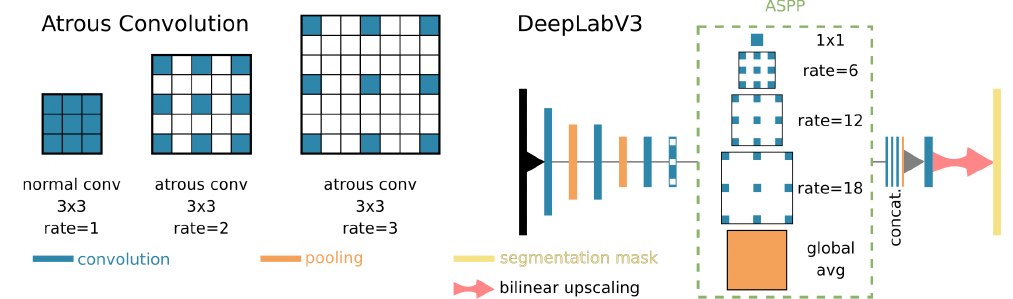
Figure 11. Conceptual overview of atrous convolution ( left ) and the Atrous Spatial Pyramid Pooling module (ASPP) within the DeepLabV3 [59] architecture ( right ). In atrous convolution, “holes” are inserted into the kernel. They provide a larger receptive field and maintain resolution at the same time. The ASPP module combines atrous convolutions of different rates and global image context via global average pooling in order to exploit feature maps on different scales efficiently